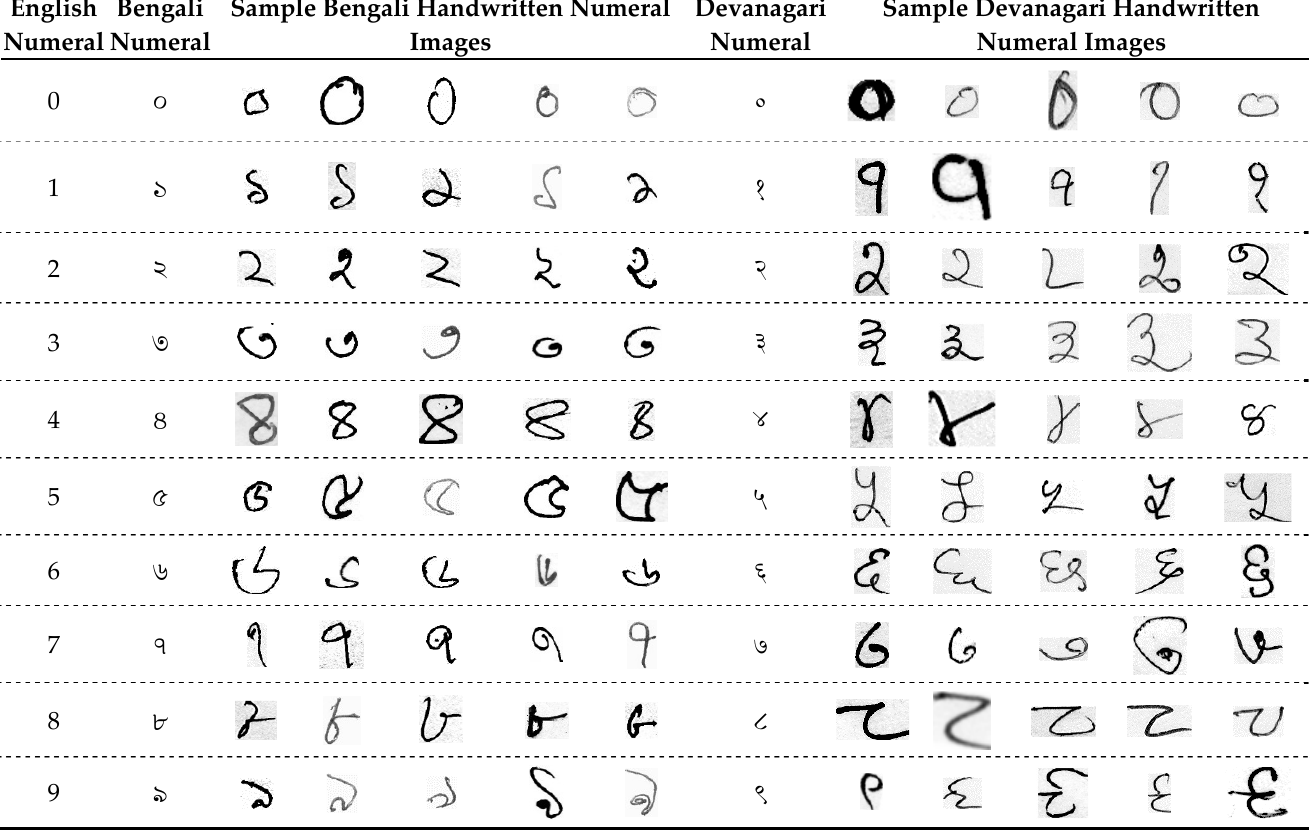
Table 1. Handwritten numeral samples from ISI Bengali and Devanagari datasets.